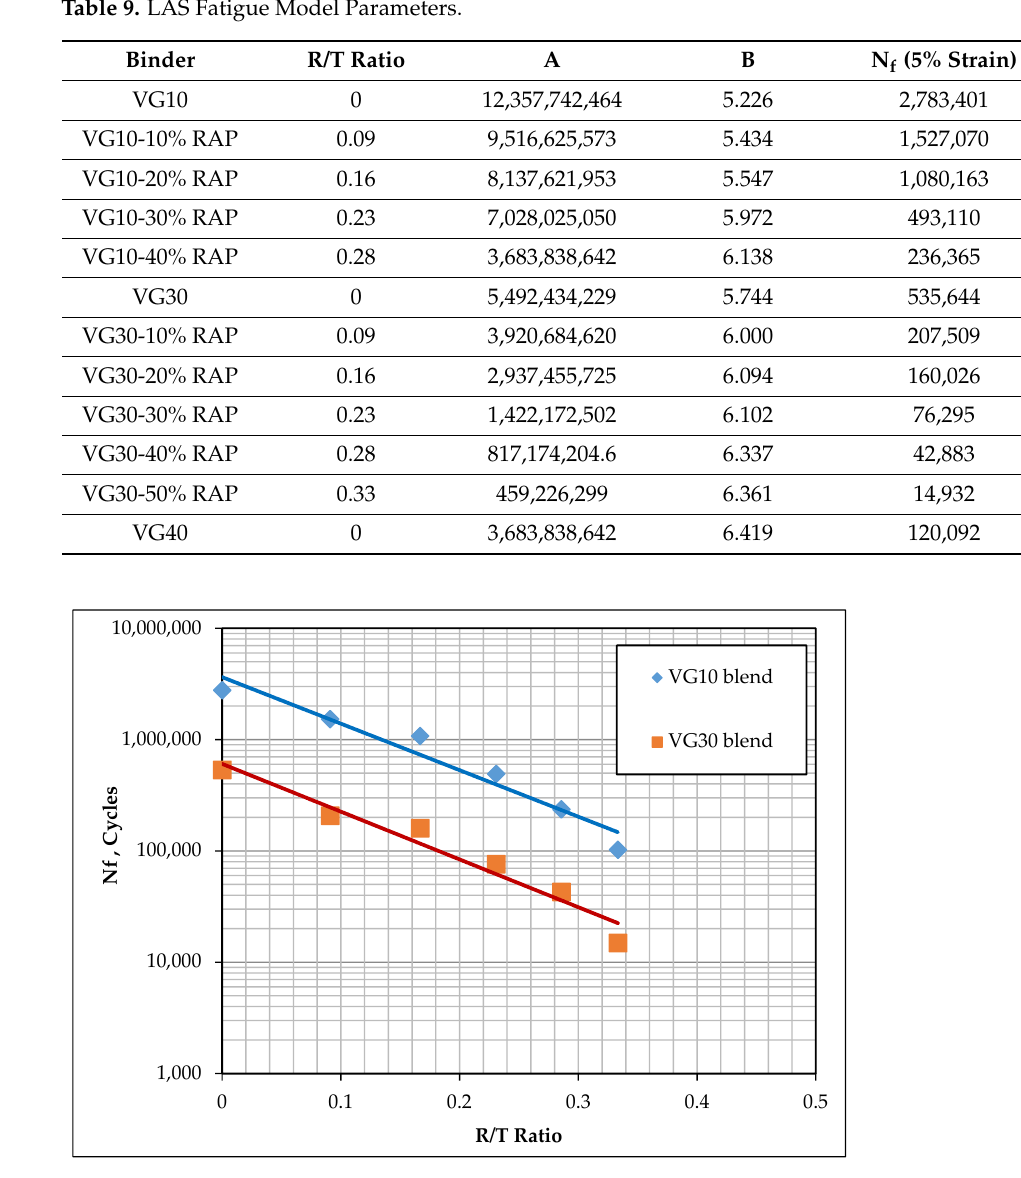
Figure 4. Binder Fatigue Lives at Different RAP% Estimated Using LAS Test Results. Table 10. LAS Fatigue Model Parameters.